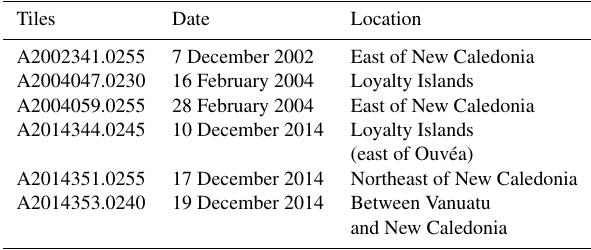
Table 2. Satellite image with in situ observations used to analyze Trichodesmium mat and adjacent